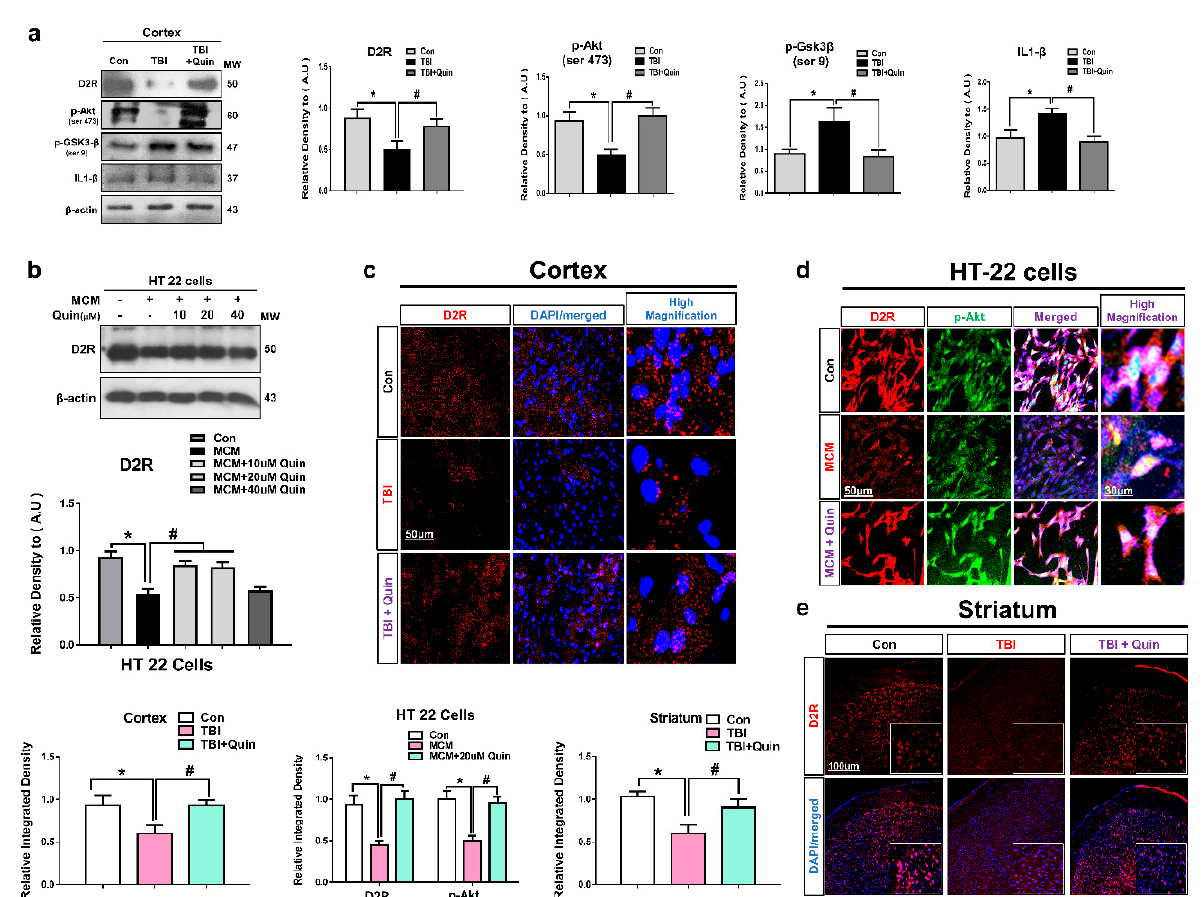
Figure 1. Quinpirole regulates the D2R/Akt/GSK3- β signaling pathway after brain injury. ( a ) Representative Western blot and histogram analysis of D2R, p-Akt, p-GSK3- β , and IL1- β in the ipsilateral cortex of an injured mouse brain. ( b ) Representing the Western blot analysis of D2R in HT22 cells. The β -actin was used as a loading control ( n = 5). Western blot bands were quantified using the SigmaGel software. ( c ) Image showing results of immunofluorescence testing for D2R expression in the ipsilateral cortex of the control, brain injury, and quinpirole-treated mice groups. ( d ) D2R expression level and p-Akt co-localization in HT22 cells. ( e ) Image showing results of immunofluorescence testing for D2R expression in the ipsilateral straitum of the control, brain injury, and quinpirole-treated mice groups, with respective bar graphs (magnification ×10, n = 6). Data were obtained following three independent experiments. The ImageJ software was used for quantitative analysis of the confocal microscopy images and the maximum fluorescent intensity in the representative field was taken(green, FITC; red, TRITC; blue, DAPI). Values are represented as mean ± SEM. We performed the one-way ANOVA test followed by post-hoc analysis. A p value < 0.05 was considered statistically significant. * significantly different between control and brain injury groups, # significantly different between the brain injury and quinpirole-treated groups. ANOVA: analysis of variance, D2R: dopamine D2 receptors, GSK3- β : glycogen synthase kinase 3 beta, IL: interleukin, SEM: standard error of mean.